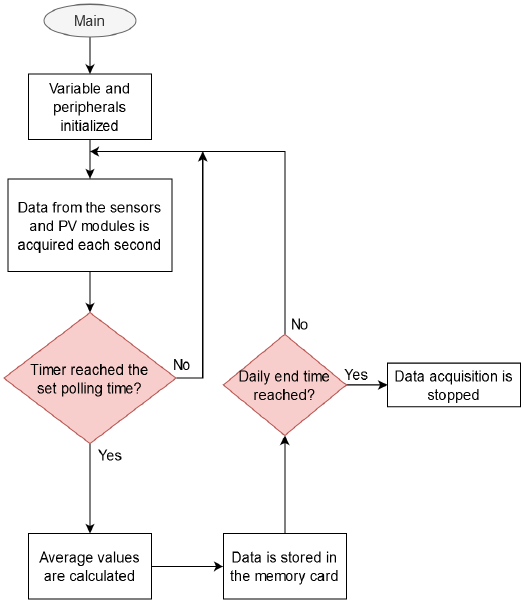
Figure 5. Flowchart of the data acquisition process in the main function of the